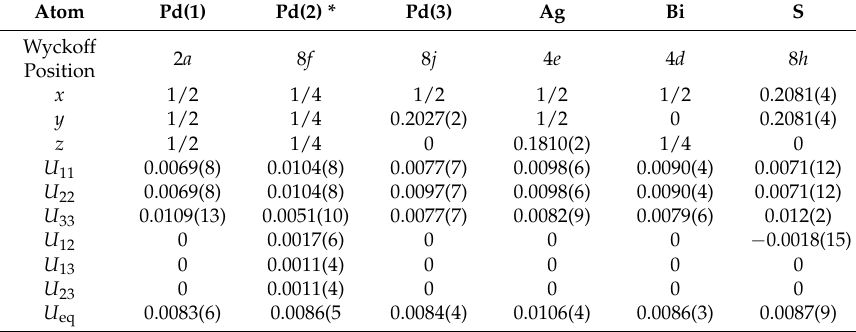
Table 4. Fractional coordinates and anisotropic displacement parameters (Å 2 ) for synthetic thalhammerite.